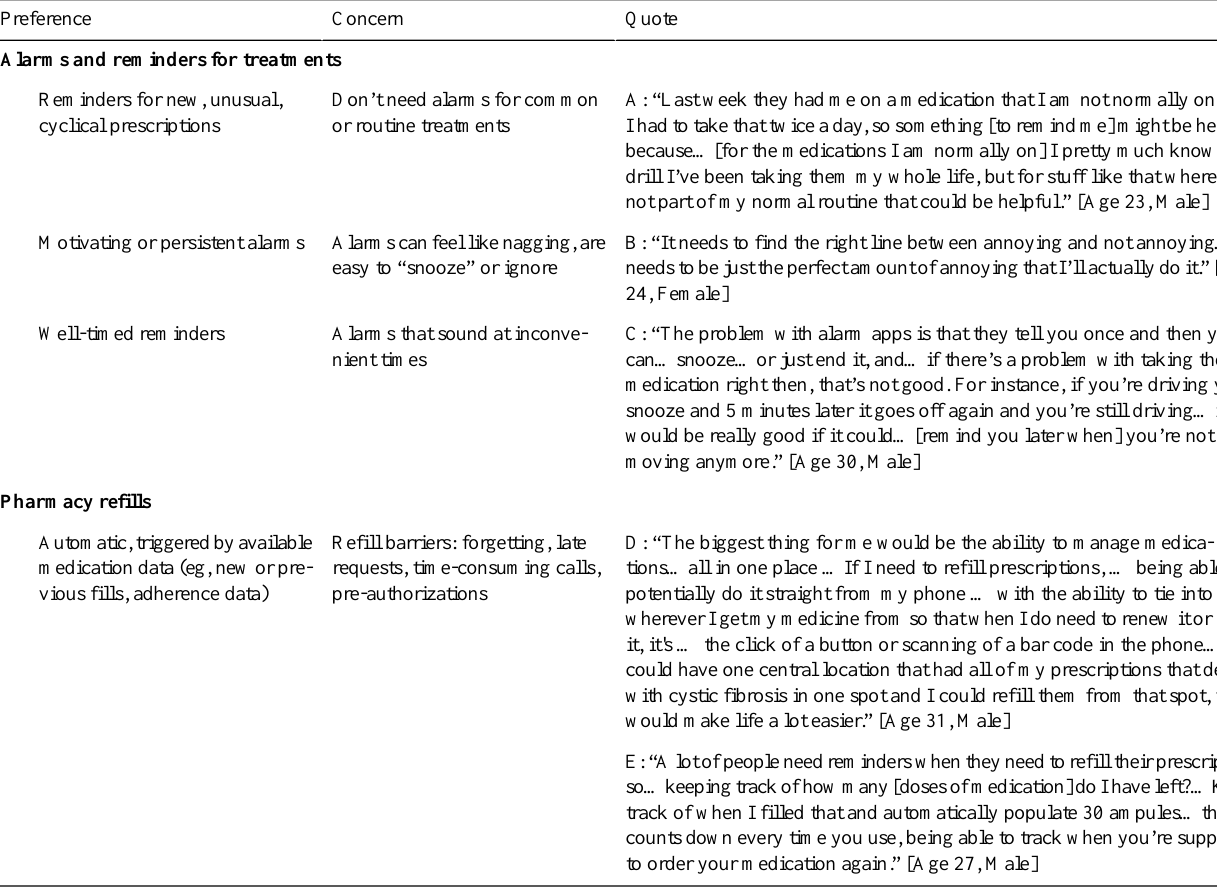
Table 3. Participant preferences, concerns, and illustrative quotes regarding Automation and Integration theme. QuoteConcernPreference Alarms and reminders for